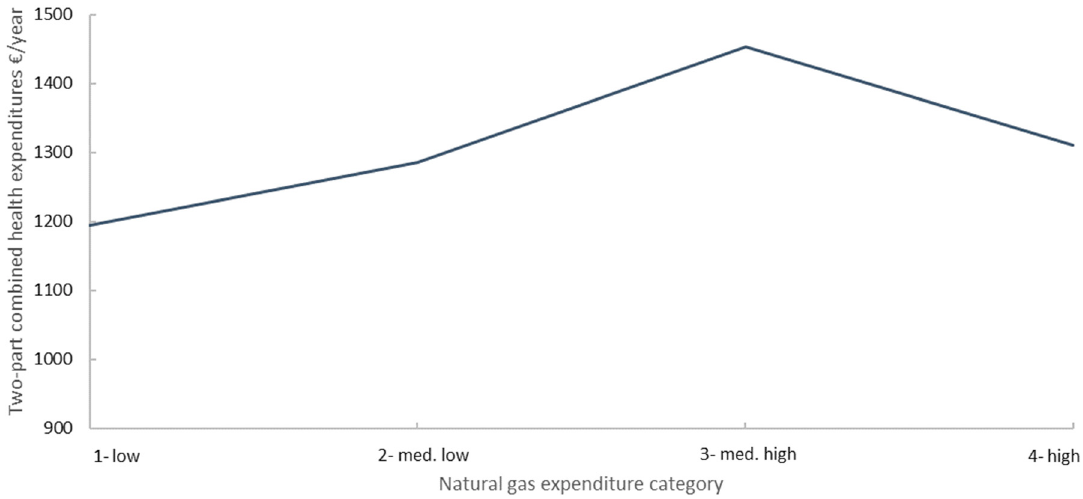
Figure 3. APP for health expenditures by natural gas expenditure.